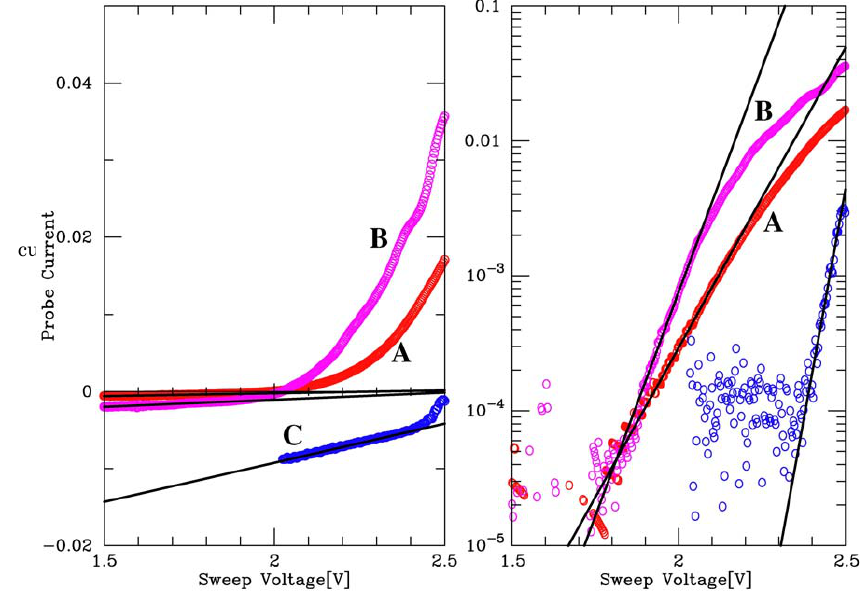
Fig. 6a. Three v-i characteristic curves (left) and semi-log plotted electron currents (right) obtained at 3 heights denoted as A, B, and C, which are marked in Fig. 5. Fig.6a. 3 v- i characteristic curves (left) and semilog ･ plotted electron currents (right) obtained at 3 heights denoted as A.B, and C which are marked in Fig.5